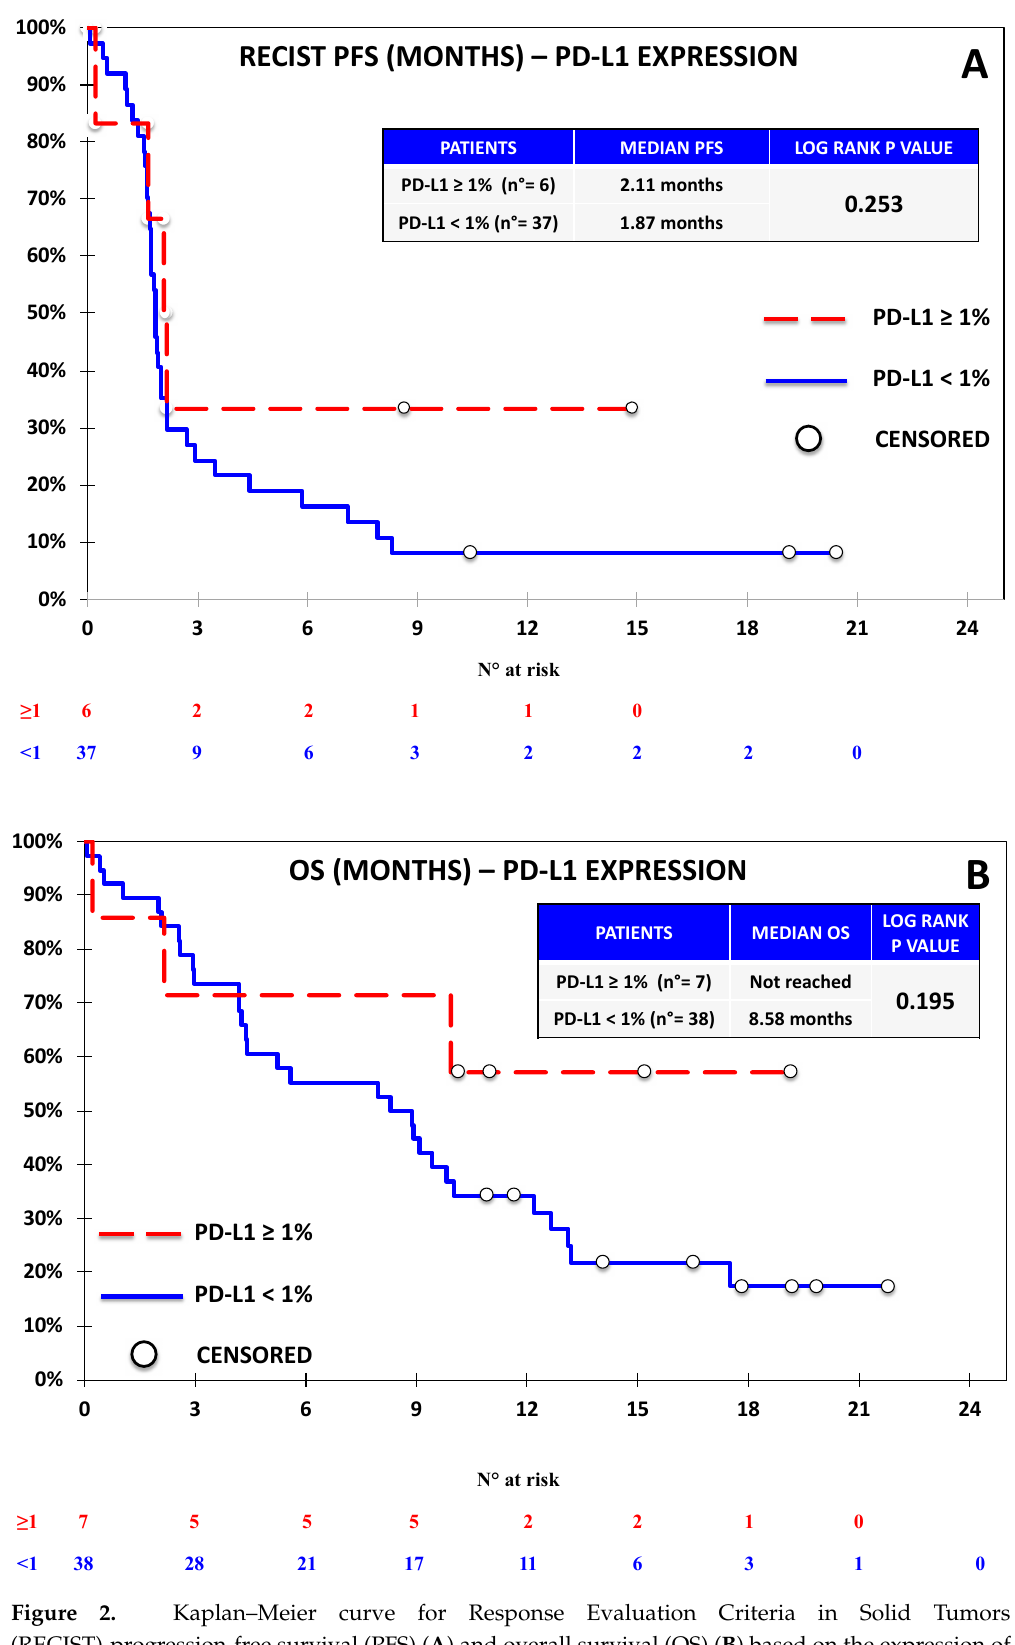
Figure 2. Kaplan–Meier curve for Response Evaluation Criteria in Solid Tumors (RECIST)-progression-free survival (PFS) ( A ) and overall survival (OS) ( B ) based on the expression of PD-L1 defined as ≥ 1% vs. <1% in the Nivolumab Cohort. No significant difference was observed on the basis of PD-L1 expression.